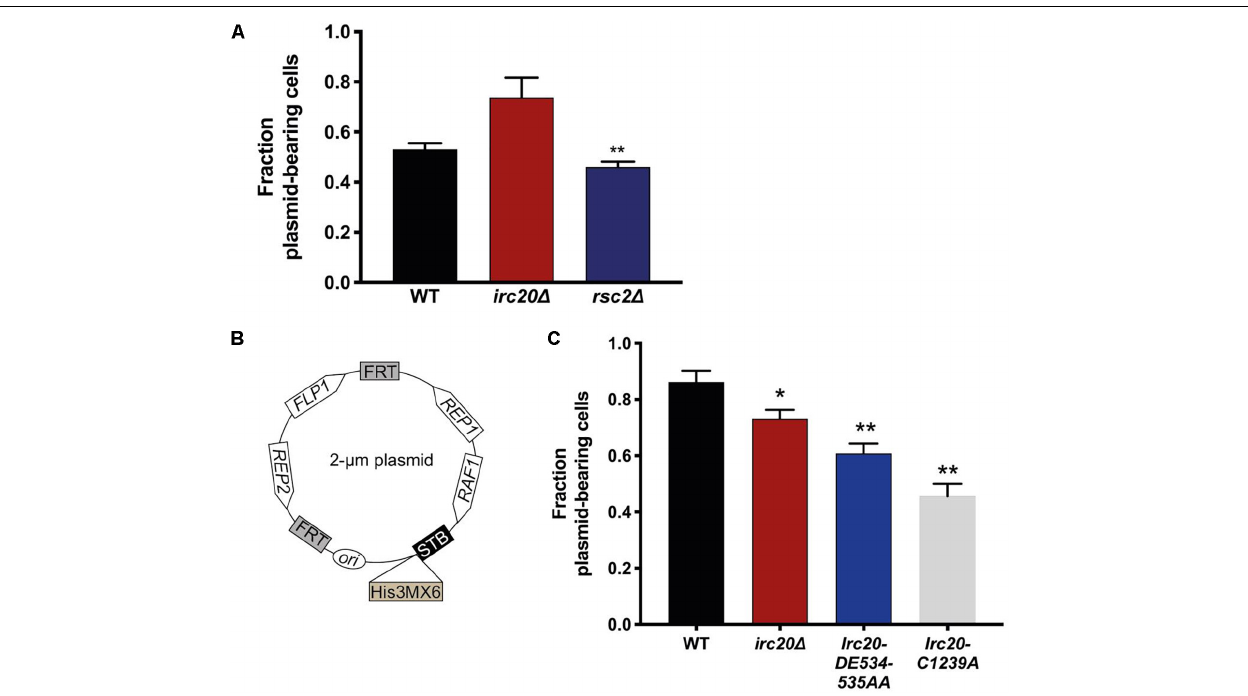
FIGURE 1 | Mutations in Irc20 affect the segregation efficiency of the 2- µ m plasmid. (A) The fraction of cells harboring pKan4 plasmid were calculated by counting the number of colonies on Geneticin plates compared to the number of colonies on non-selective plate (YPD) in three different independent cultures. (B) Schematic diagram of p2 µ m-His3MX6-STB, a modified form of the 2- µ m plasmid where a His3MX6 cassette is inserted downstream of the STB locus to allow for selection. (C) The fraction of cells harboring p2 µ m-His3MX6-STB plasmid were calculated by counting the number of colonies on SD-His plates compared to the number of colonies on non-selective plates (YPD) in three different independent cultures. Values are presented as mean ± SEM. One asterisk shows p -value < 0.05, two asterisks shows p -value < 0.01, as compared to